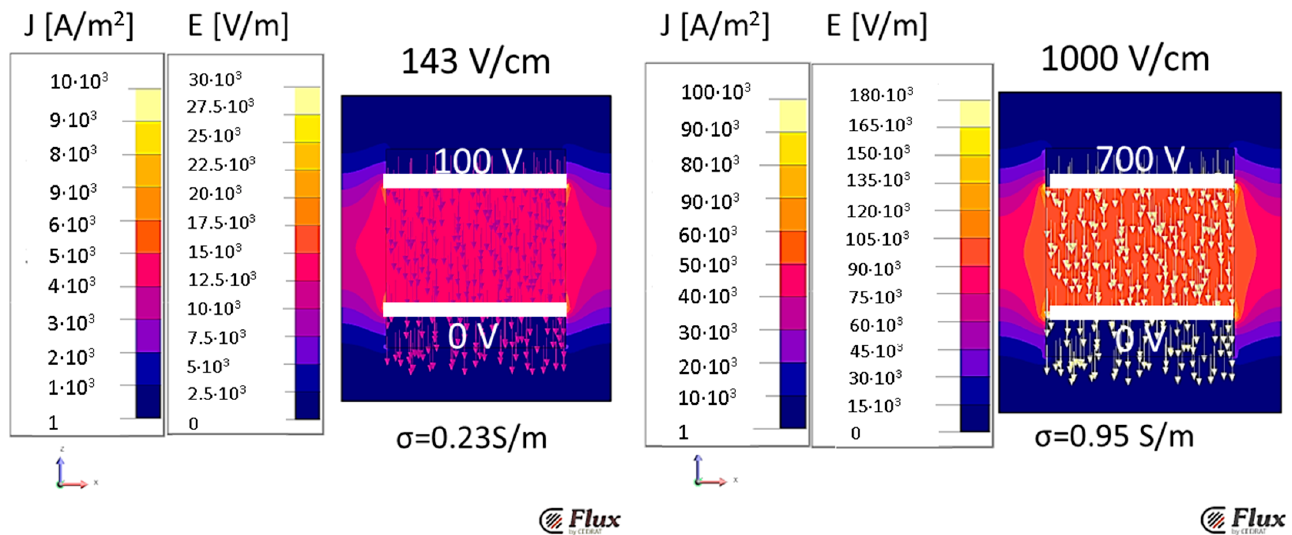
constant electric conductivity for different applied voltages, ( a ) 143 V/cm, ( b ) 1000 V/cm.